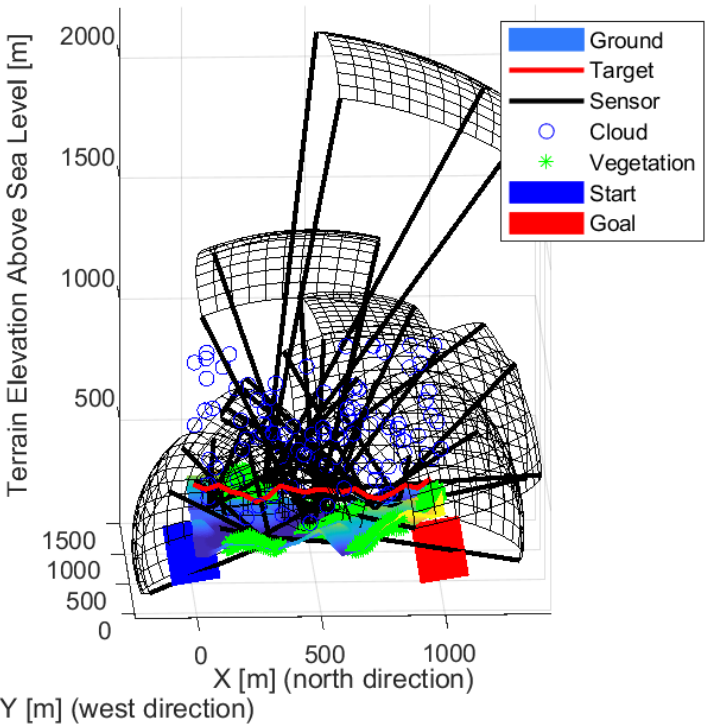
Figure 19. The solution in the case of the thirteen sensors from the side